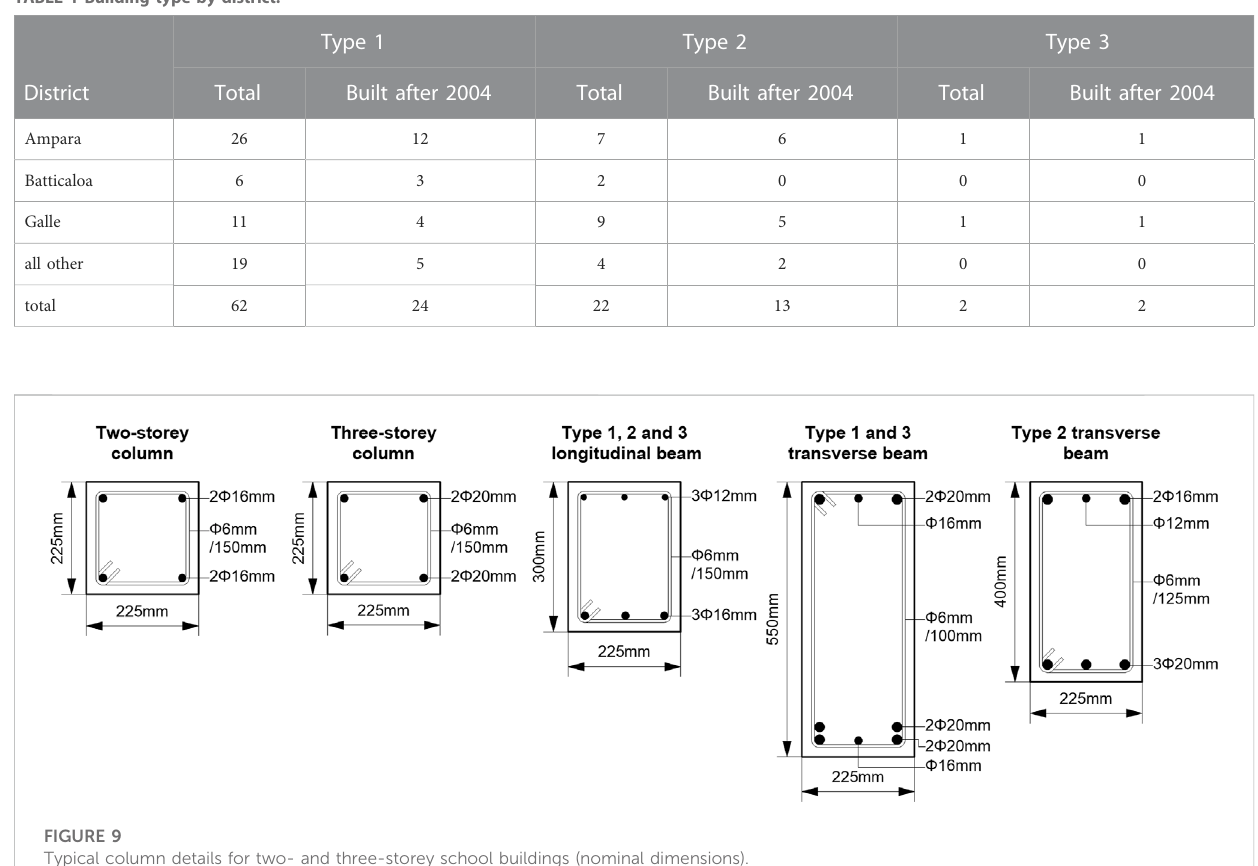
TABLE 1 Building type by district.